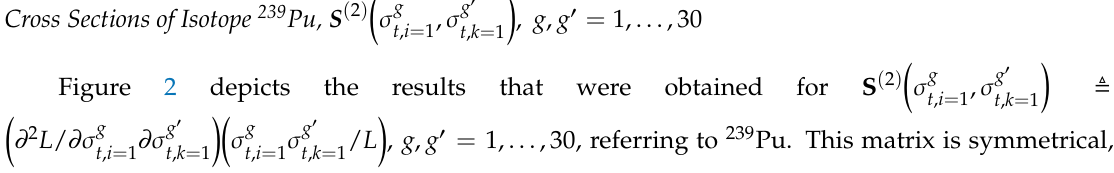
Figure 2 depicts the results that were obtained for S ( 2 )